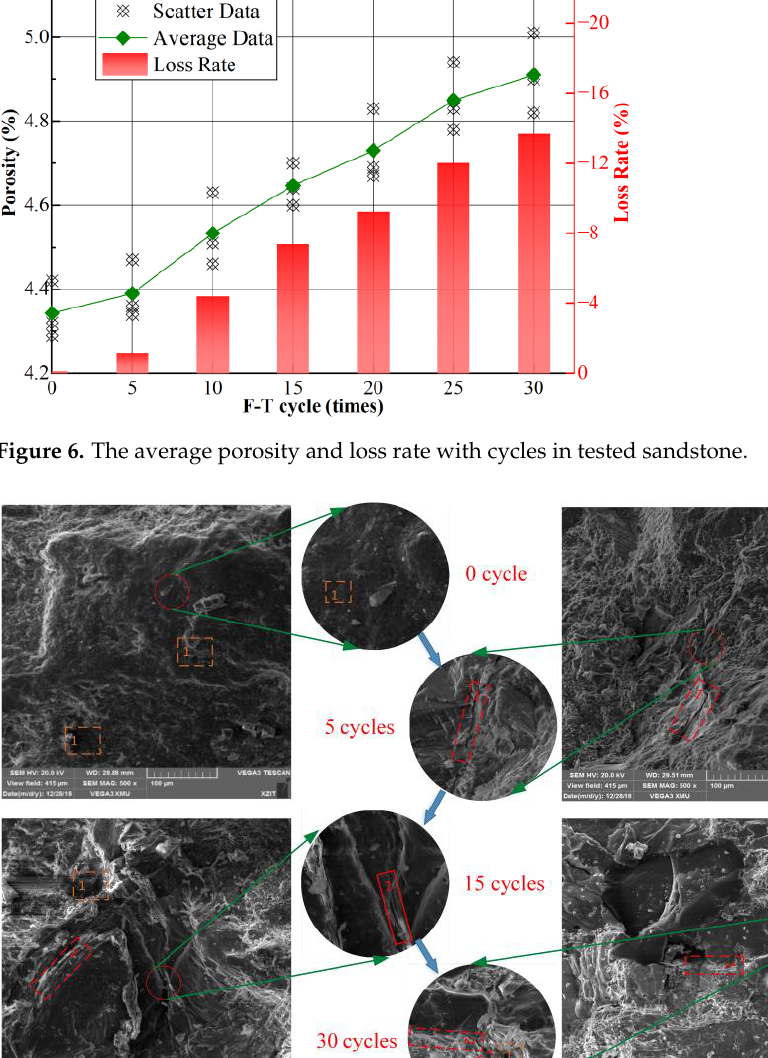
Figure 8. The average P-wave velocity and loss rate with cycles in the tested sandstone.